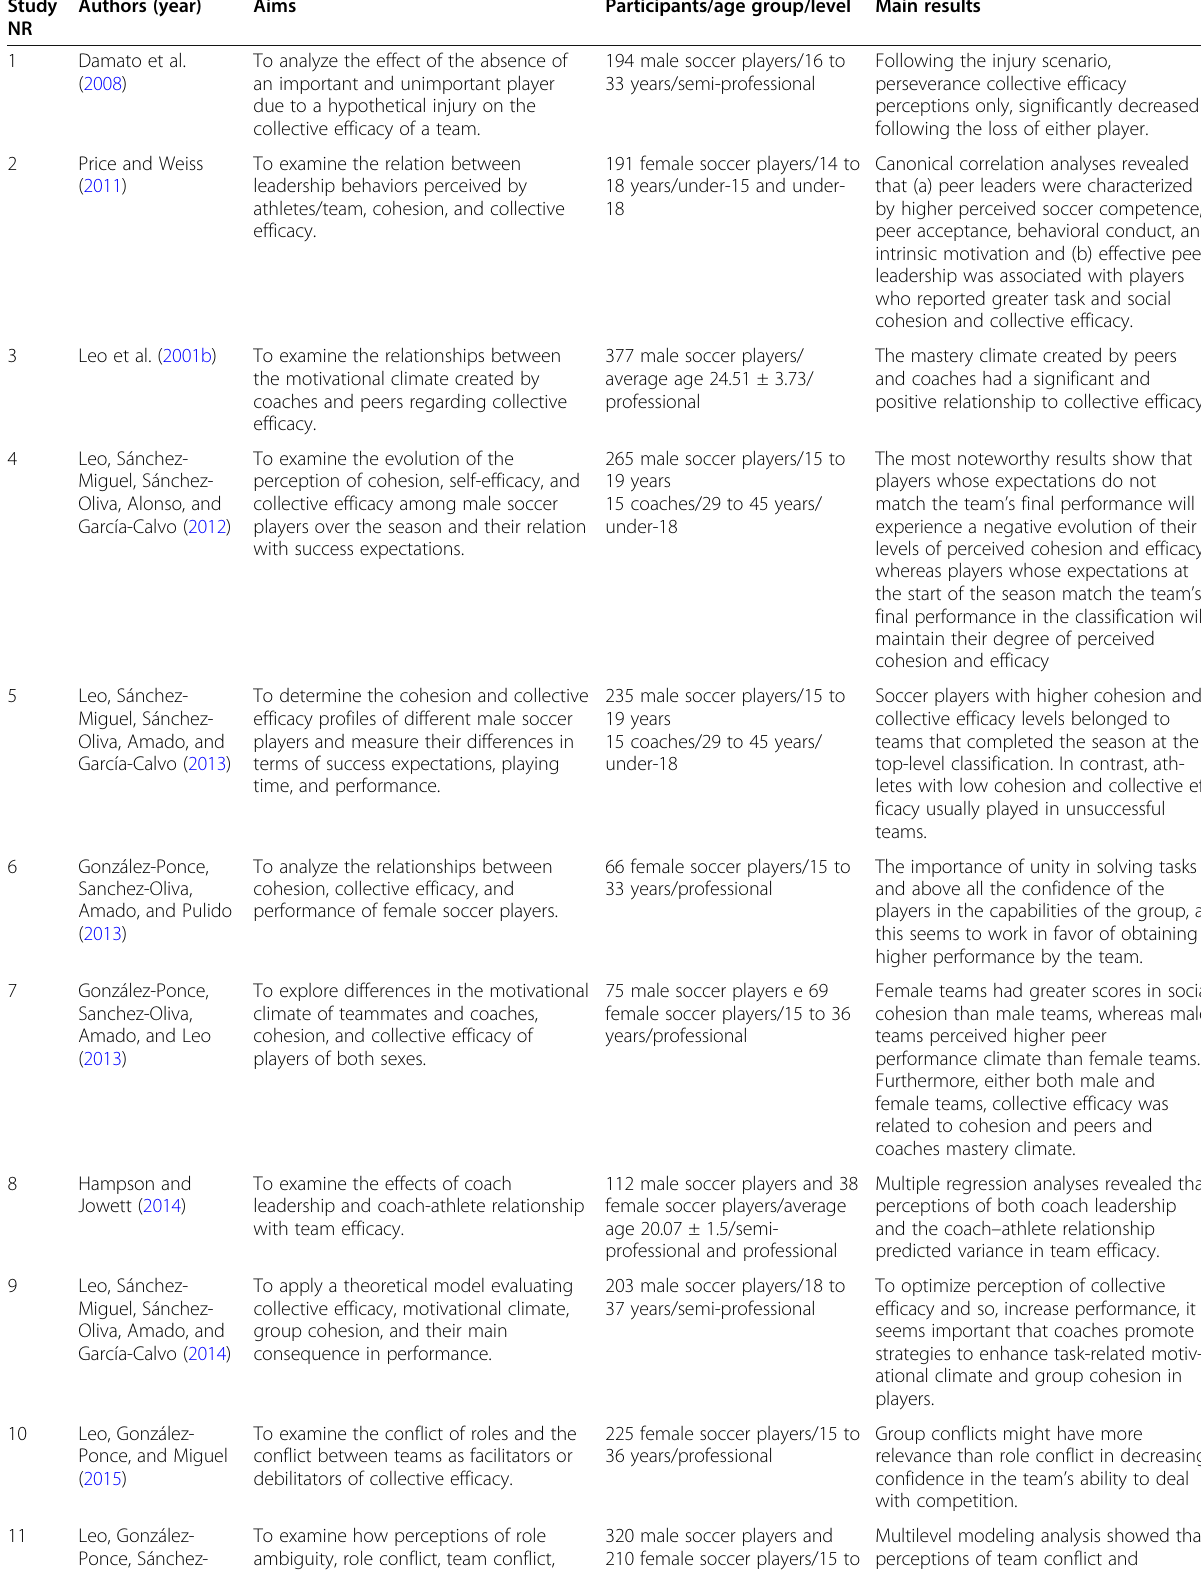
Table 1 Characterization of the studies included in the systematic